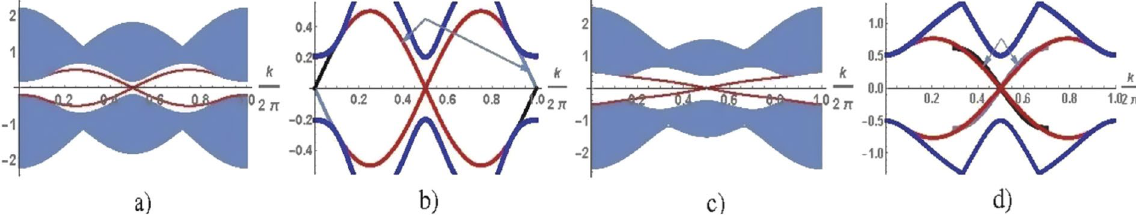
Figure 1. The band structure of TSC in the stripe geometry. The bulk spectrum (denoted by blue lines) with edge modes (red lines) as a function of the momentum k directed along the edge ( a , c ), the low-energy modes of the bulk spectrum, edge modes and solution (9) for comparison (black lines also marked by arrows) ( b , d ). The energies are calculated at ∆ = 1 , µ = 1 , τ = 0 ( a , b ); Δ = 1, µ = 1 , τ = 1 , Q = π ( c , d ). At μ ≠ 0 τ = 0 ( a ) and 2 5 2 2 Q = π , τ < τ c ( c ), the edge modes populate the gap, merge with the bulk states, intersect at the Dirac point k = π